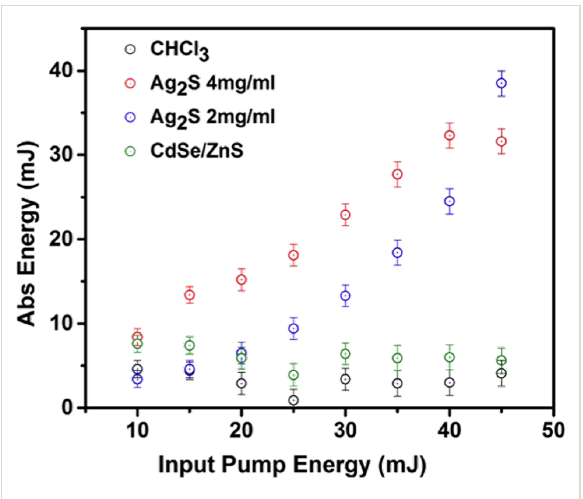
Figure 7 shows the output energy as a function of the input pump energy at different concentration values. The intensity of the absorption is defined as the ratio of the output energy to the input pump energy. It is shown that at the different pump levels, the Ag 2 S sample with a higher concentration (4.0 mg/mL) produced a smaller output energy than the Ag 2 S sample with a lower concentration (2.0 mg/mL). CHCl 3 produced the lowest absorption intensity. Ag 2 S exhibited stronger absorption compared with CHCl 3 as the pump energy increased. This can be explained by the fact that there are many impurities and elec- tron–hole pairs in QDs. Also, when the laser interacts with QDs the dielectric constant of the medium surrounding the QDs will be changed. Ag 2 S has a narrow band gap, which leads to the strong absorption characteristics of Ag 2 S and which makes Ag 2 S particularly suitable for use in optical detectors and solar